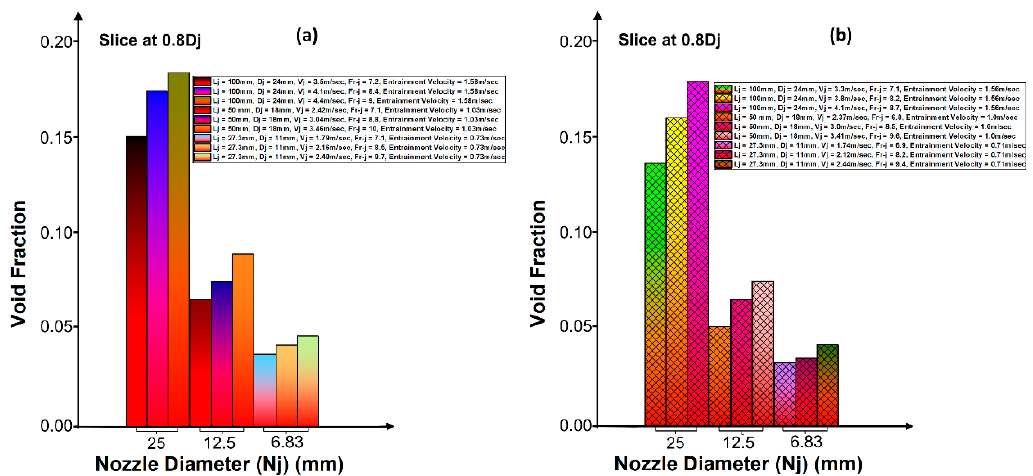
Figure 6. ( a ) VOF Simulated Values; ( b ) Chanson [39] Measured Values for a Peaked Void Fraction at 0.8 D j Depth.